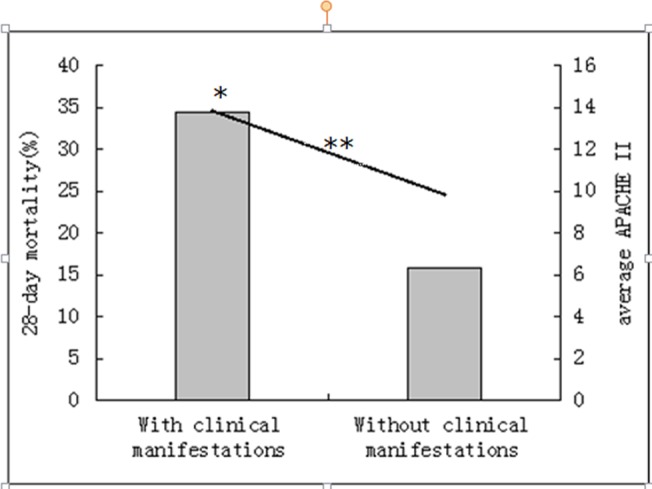
Acute Physiology and Chronic Health Evaluation II (APACHE II) score and 28-day mortality by the clinical manifestation.Bar graph shows 28-day mortality (*p = 0.000). Line graph shows the average APACHE II score (**p = 0.000).